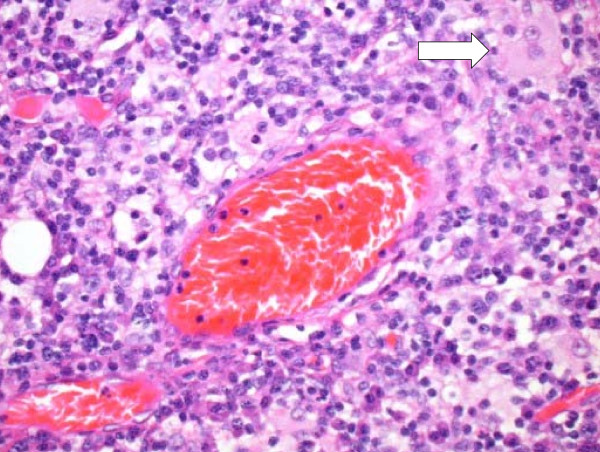
High Power showing sickled red cells in a vessel and details of the epithelioid histiocytes (white arrow) which contain lymphocytes within their cytoplasm.